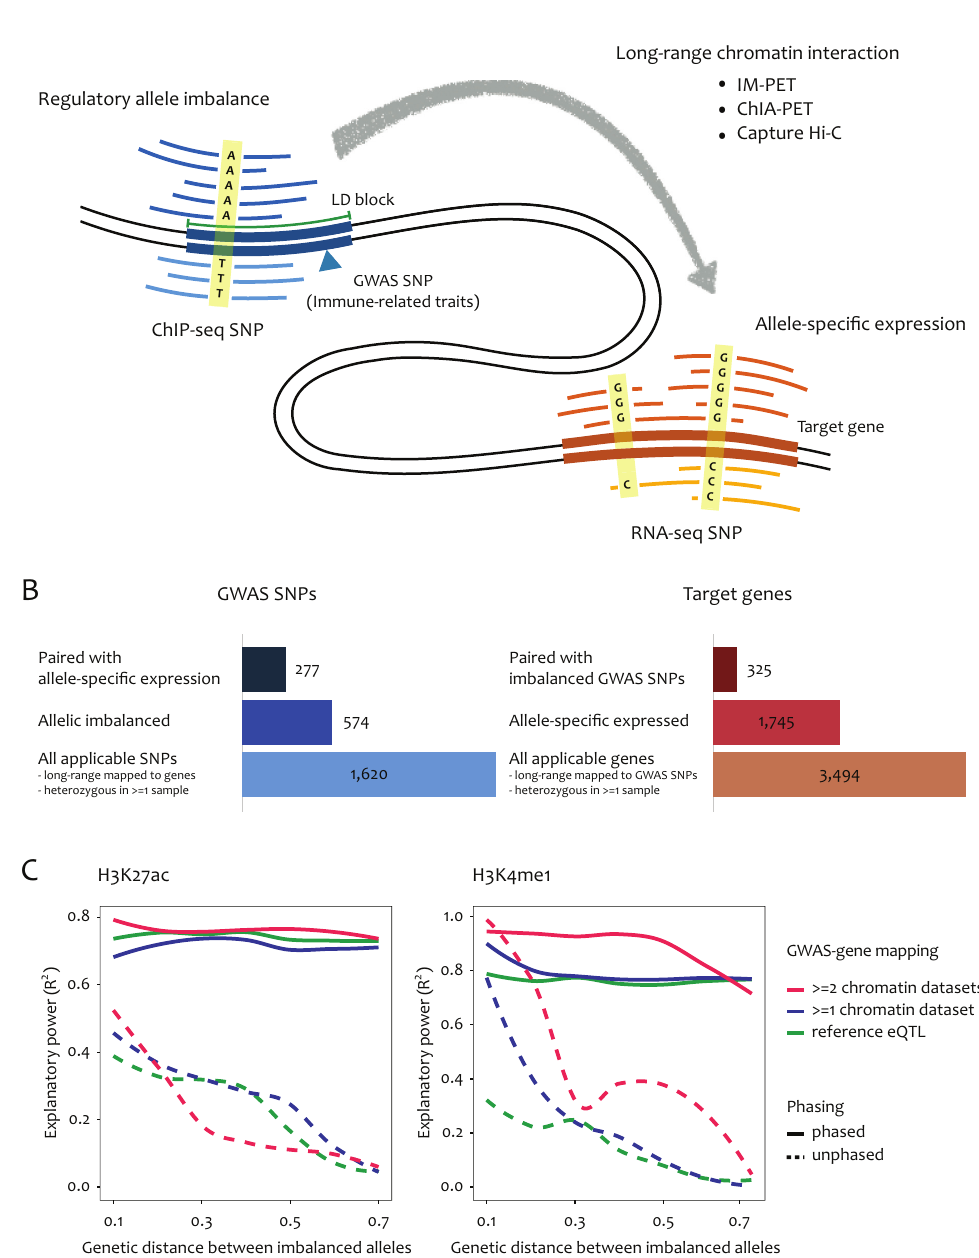
Fig 1. Summaryof long-range allele-specific mapping. (A) Schematic view of our method. We first search for SNPs causingallele imbalance in ChIP-seq reads within the LD block of a given GWAS SNP. We then search for allele-specific expressionof transcripts connectedvia chromatin interaction. The imbalance SNPs are paired when the regulatorydirectionof their phasedgenotypes matches with each other (i.e., when the major regulatory alleleand major transcript alleleare on the same chromosomefor the activatinghistone marks). (B) The number of GWAS SNPs (upper) and target genes (lower) at the beginning,after alleleimbalanceanalysis, and after long- range pairing(from bottom to top). The applicable SNPs and genes were definedas being heterozygous in at least one sample and possessing chromatininteraction. (C) Explanatorypower indicating the extent to which allele-specific expressionis explained by allele-specific cis -regulation. Linear regression was performed where the RNA-seq alleleratio was regressed on the pairedChIP-seq alleleratio. Pairingwas done by chromatin interactionversus eQTL mappingwith phased versus unphased